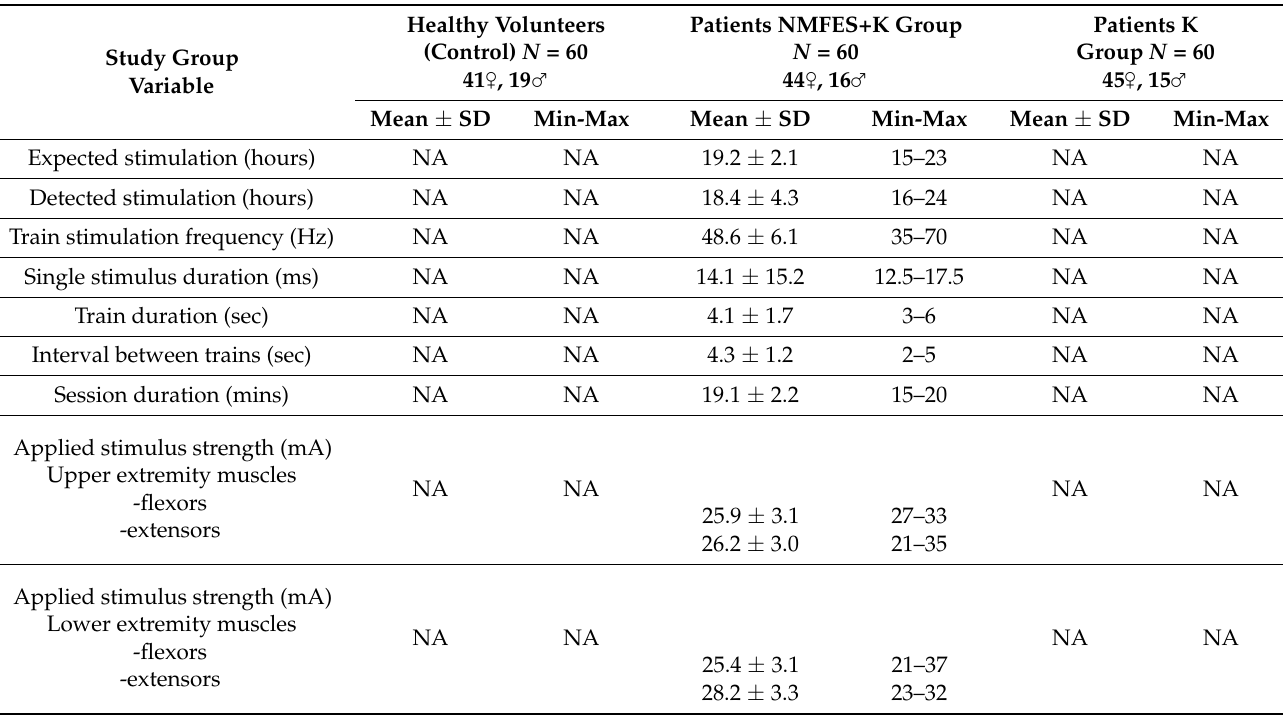
Table 2. Characteristics of the subjects and the summary of applied electrotherapy